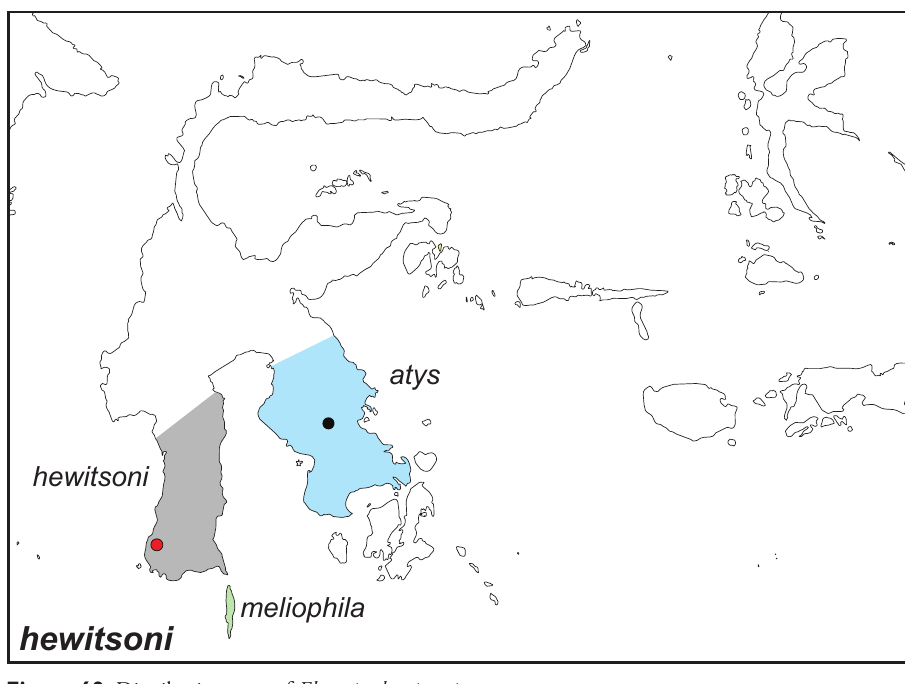
Figure 69. Distribution map of Elymnias hewitsoni .